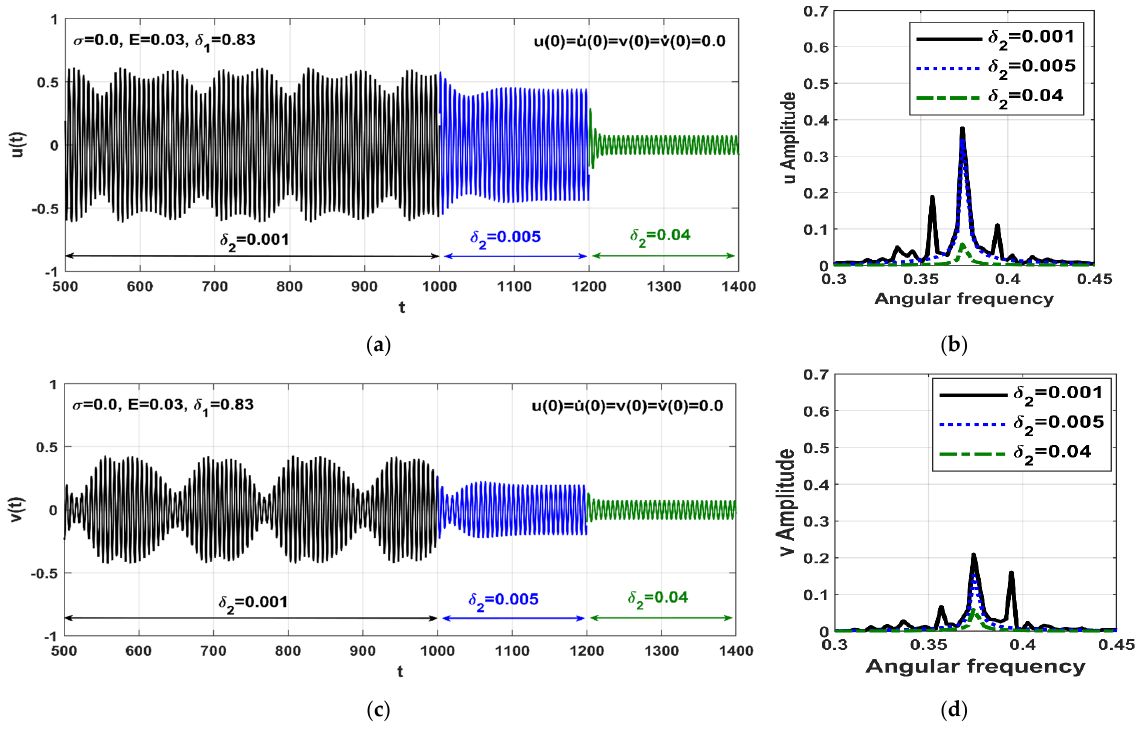
Figure 17. Time-response and the corresponding frequency-spectrum of the controlled Jeffcott-rotor according to Figure 16 at the initial conditions 𝑢(0) = 𝑢(cid:4662)(0) = 𝑣(0) = 𝑣(cid:4662)(0) = 0 and parameter values 𝜎 = 0,𝐸 = 0.03,𝜆 = 0.05,𝛿 (cid:2869) = 0.83 when increasing the derivative gain online from 𝛿 (cid:2870) = 0.001 to 𝛿 (cid:2870) = 0.005 at time 𝑡 = 1000 , and then from 𝛿 (cid:2870) = 0.005 to 𝛿 (cid:2870) = 0.04 at 𝑡 = 1200 : ( a , b ) the normalized temporal oscillations 𝑢(𝑡) and the corresponding frequency spectrum in 𝑋 direction, ( c , d ) the normalized temporal oscillations 𝑣(𝑡) and the corresponding frequency spectrum in 𝑌 direction.